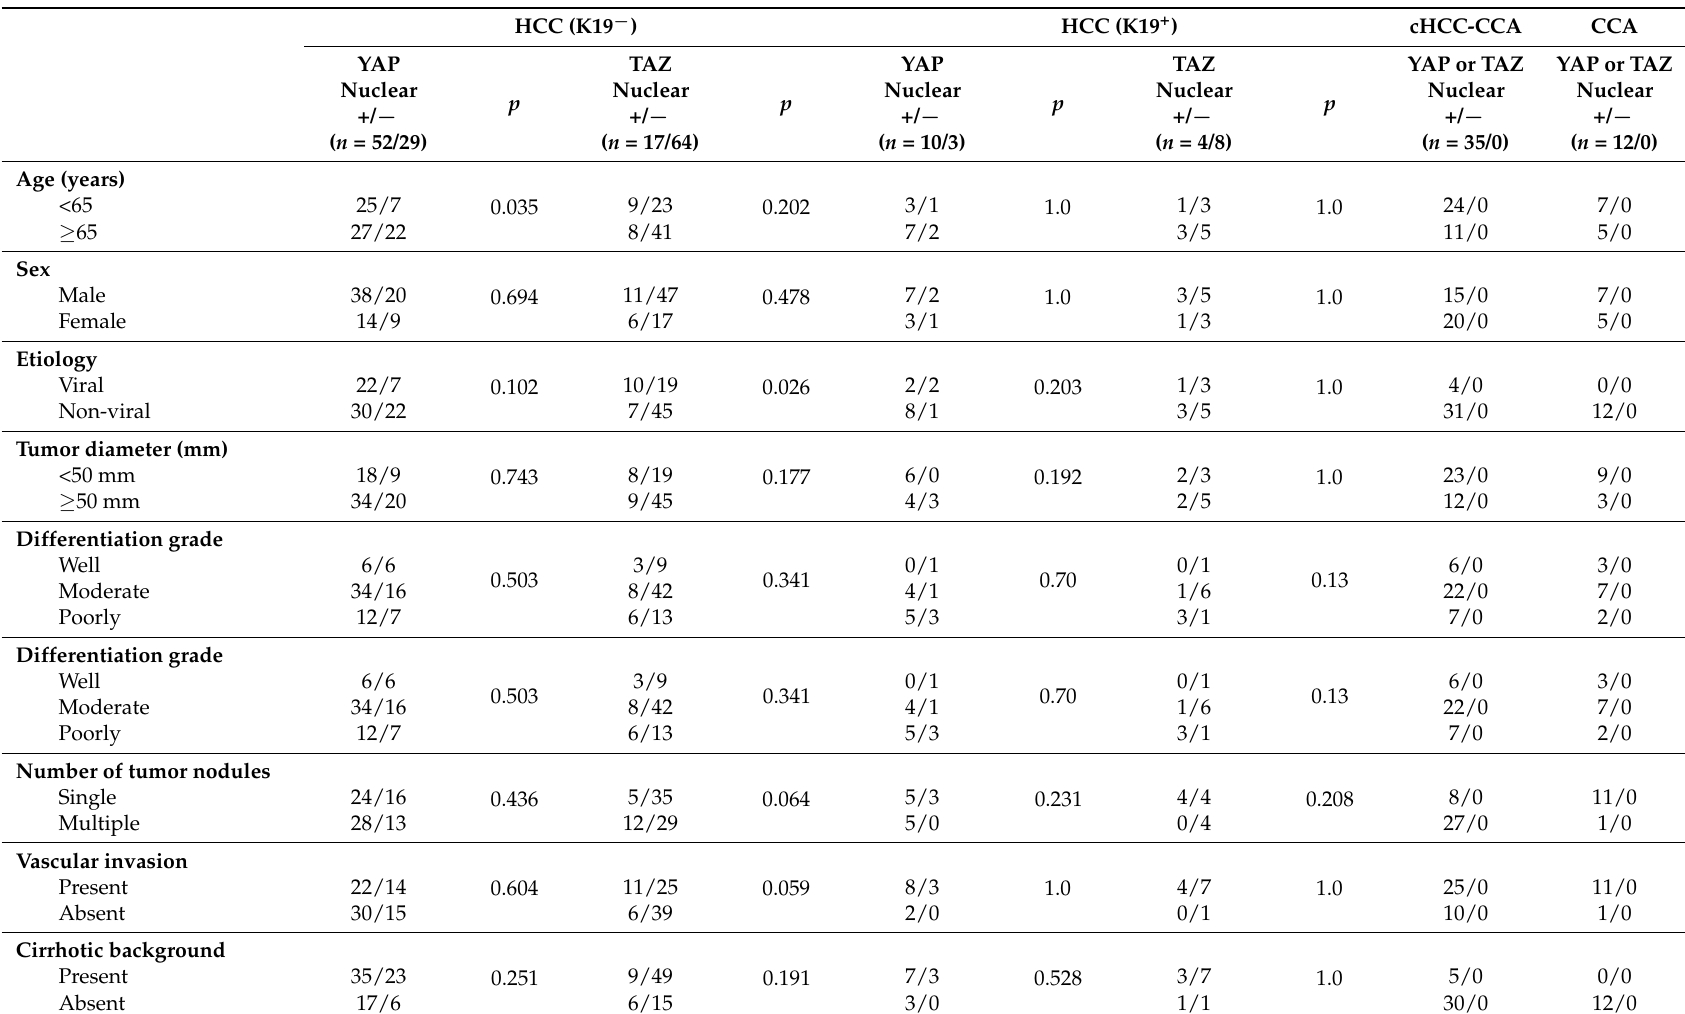
Table 2. Clinicopathological characteristics in relation to YAP and TAZ